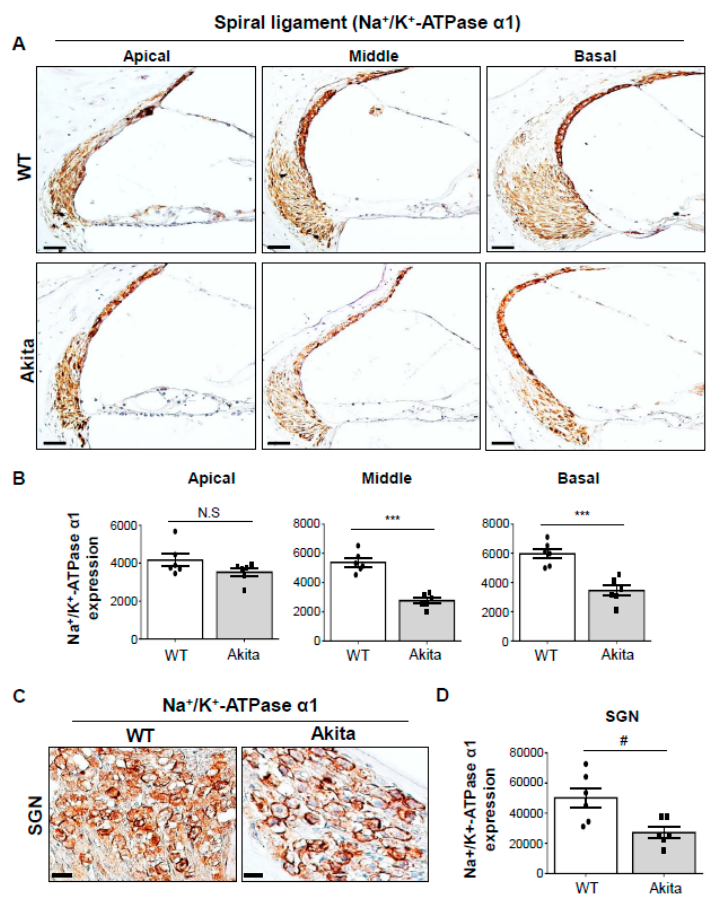
Figure 5. Quantitative analysis of Na + /K + -ATPase α 1 immunostaining in the cochleae of WT and Akita mice. ( A ) Immunohistochemistry analysis of Na + /K + -ATPase α 1 from the apical, middle, and basal turns of WT and Akita mice. Scale bar, 50 μ m. ( B ) The chromogenic intensity of Na + /K + -ATPase α 1 quantified by Image J analysis is shown for both WT ( n = 6) and Akita mice ( n = 6). ( C ) Immunohistochemistry analysis of Na + /K + -ATPase α 1 from the middle turns of the modiolus of SGNs in WT and Akita mice. Scale bar, 10 μ m. ( D ) The chromogenic intensity of Na + /K + -ATPase α 1 quantified by Image J analysis is shown for both WT ( n = 6) and Akita mice ( n = 6). Results are means ± SEM. # p < 0.05, *** p < 0.001 by Student’s t -test. N.S= not statistically significant.